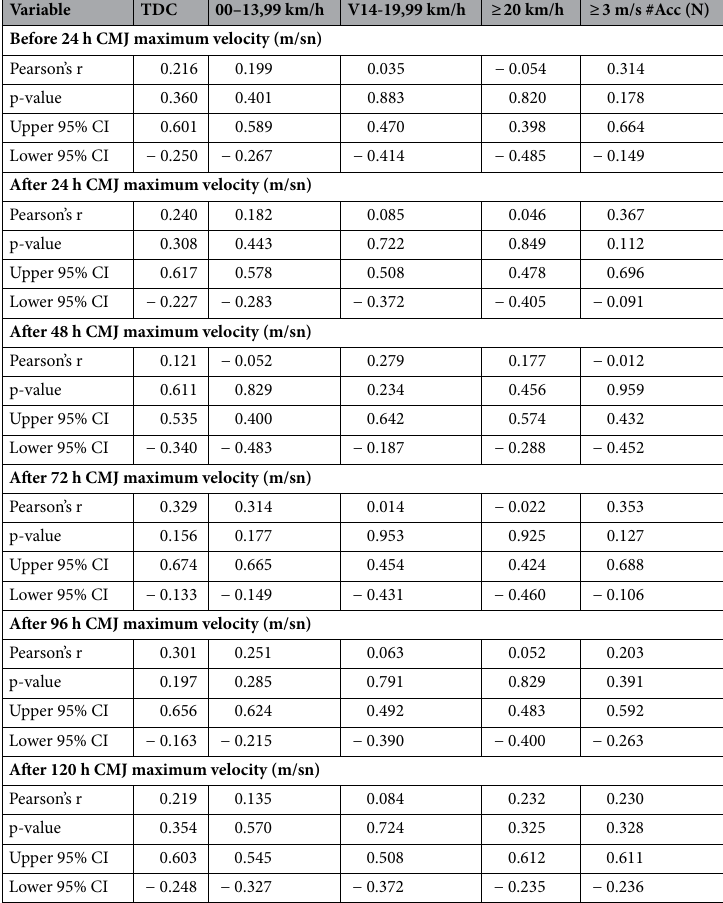
Table 5. Comparison of the match external loads and CMJ maximum velocity